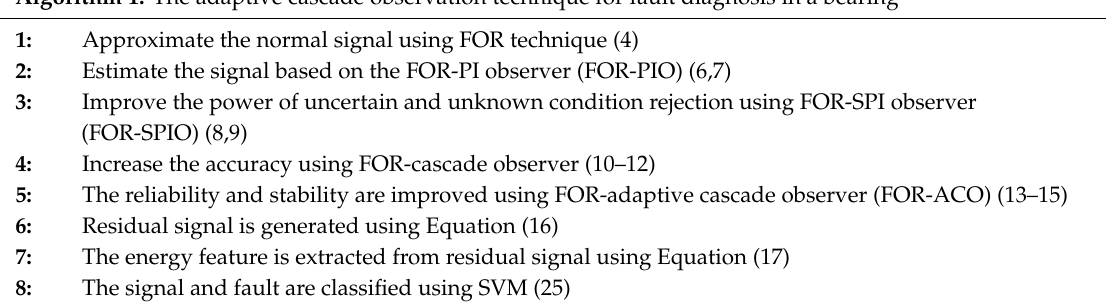
Algorithm 1. The adaptive cascade observation technique for fault diagnosis in a bearing